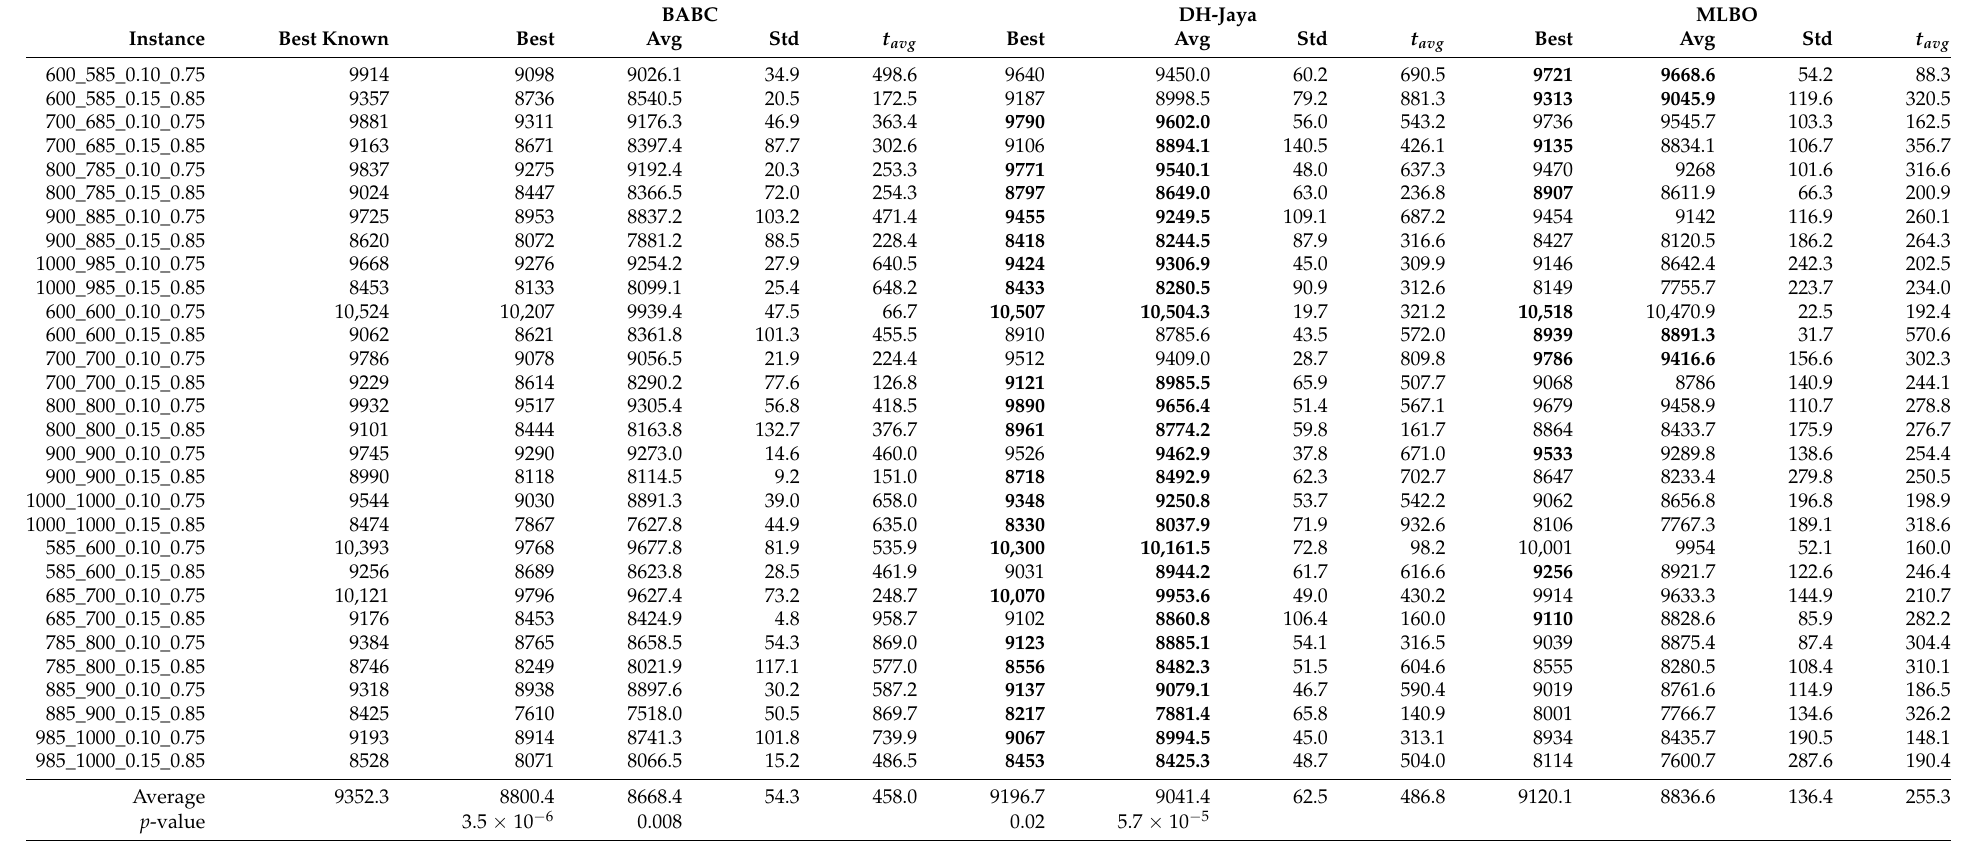
Table 8. Comparison between BABC, DH-Jaya, and MLBO algorithms for large